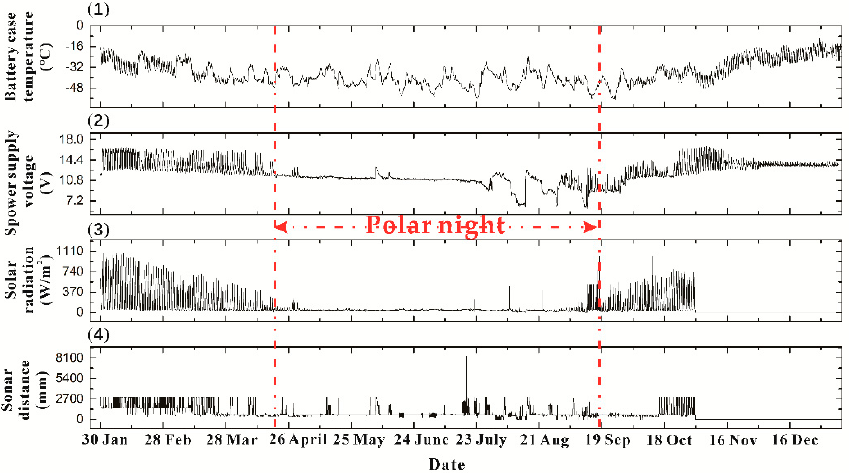
Figure 4. ( 1 ) Battery case temperature, ( 2 ) Power supply voltage, ( 3 ) Solar radiation, and ( 4 ) Sonar distance data observed by the weather station installed at Mount Tai in TYUT in 2016.